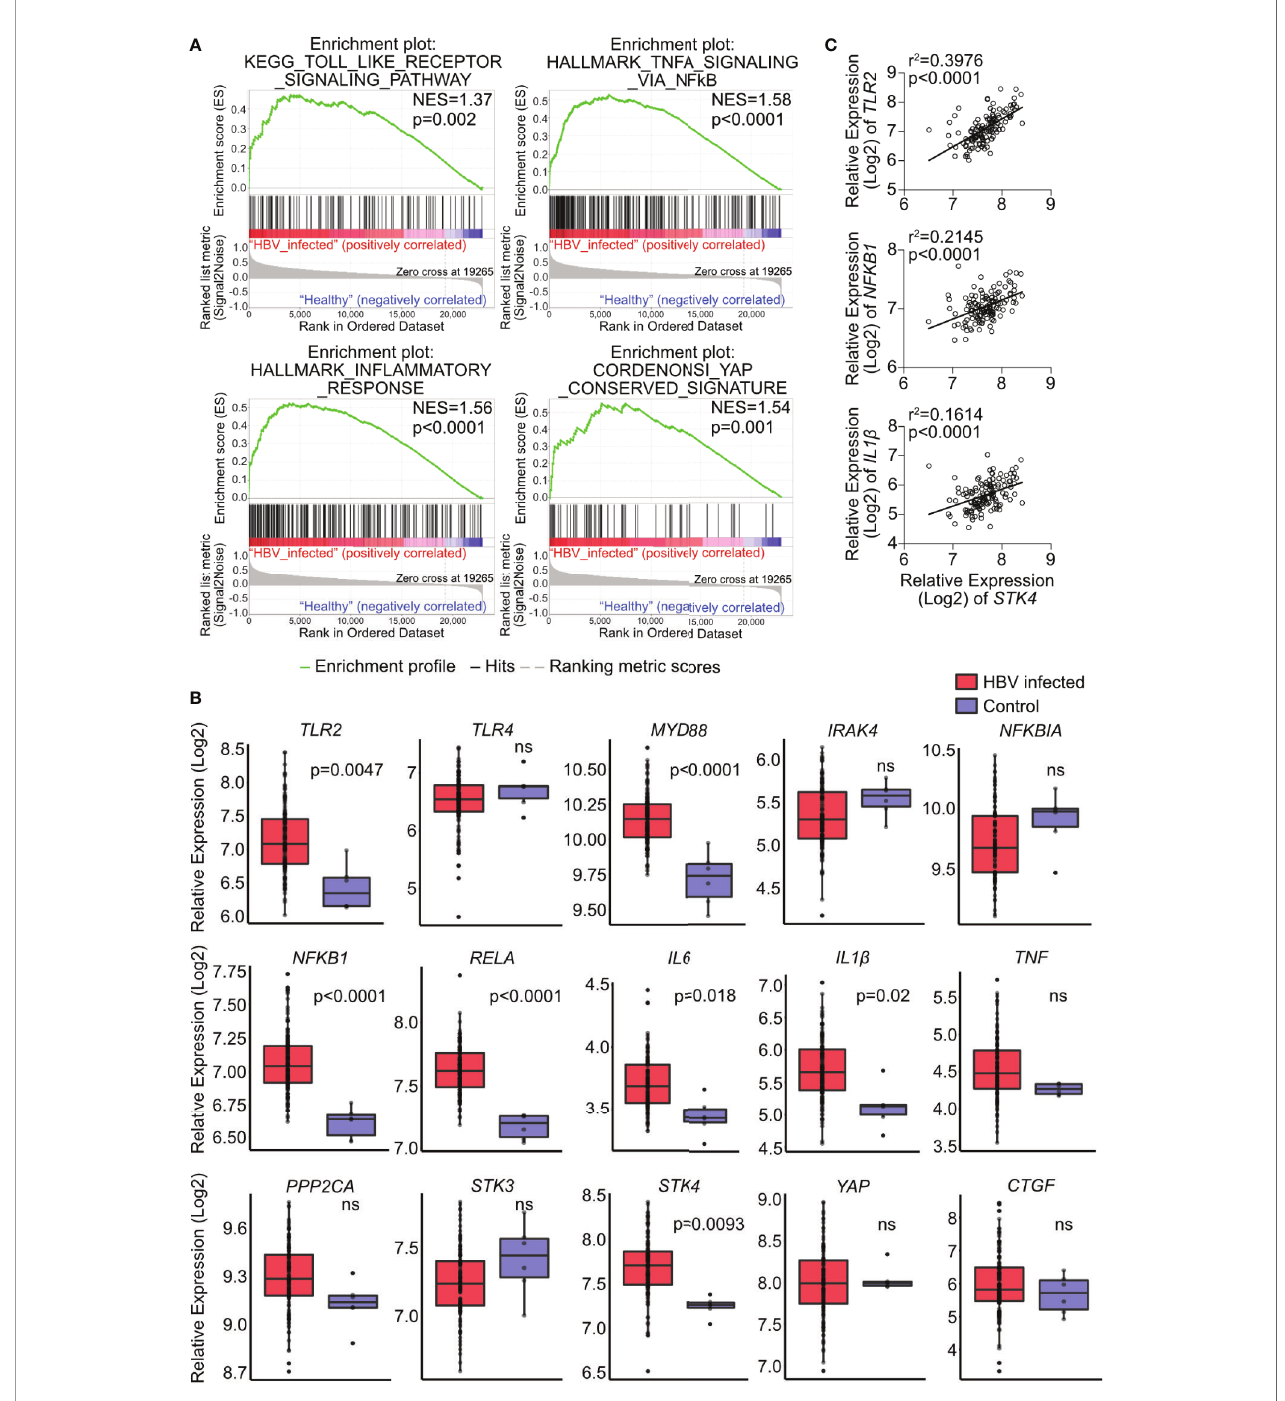
FIGURE 8 | Hepatic gene expression signatures in chronic HBV-infected patients support the relevance of TLR2-MyD88-IRAK4-Hippo axis in HBV infection. GSE83148 data set (122 HBV-infected, 6 controls) was reanalyzed to perform gene set enrichment analysis (A) . Signi fi cant gene enrichment could be shown for TLR signaling (KEGG), NF- k B signaling and in fl ammatory response (Hallmark) and YAP signature (CORDENOSI). In addition, relative expression of genes related to TLR signaling ( TLR2, TLR4, MYD88, IRAK4, NFKBIA NFKB1, RELA, IL6, IL1 b and TNF) and Hippo signaling ( PPP2CA, STK3, STK4, YAP and CTGF ) was compared between these two groups (B) . Correlation of STK4 expression (spearman) with TLR2 , NFKB1 and IL1 b gene expression was performed (C) . ns, not signi fi